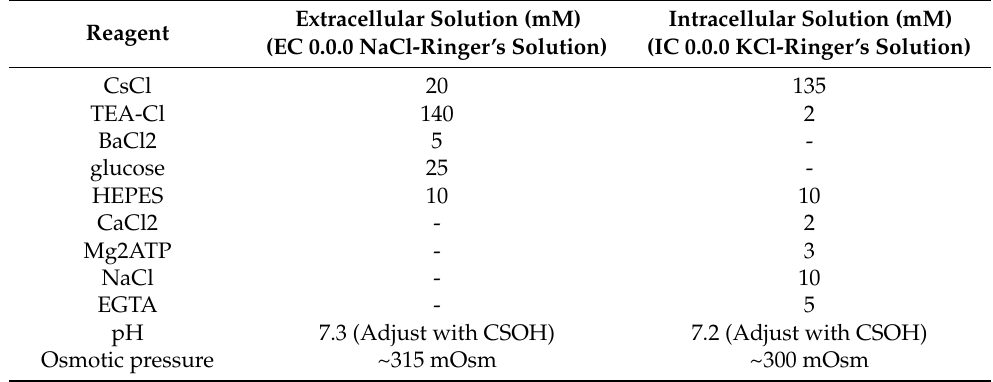
Table 7. Composition of intracellular fluid and extracellular fluid (L-type calcium channels).